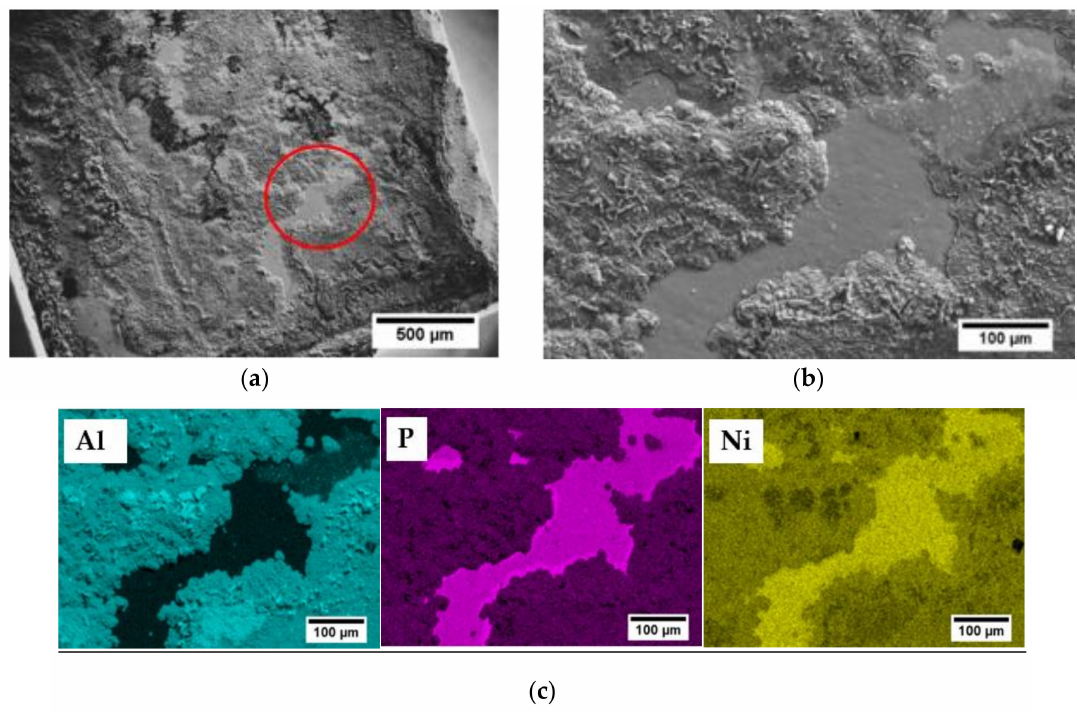
Figure 6. ( a ) Top-view of fractured Mm y (Fe,Co) 4 Sb 12 surface after apparent shear strength testing; ( b ) red circle presents the enlarged area shown in ( a ), along with elemental mapping of Al, P and Ni obtained by EDS analysis ( c ).